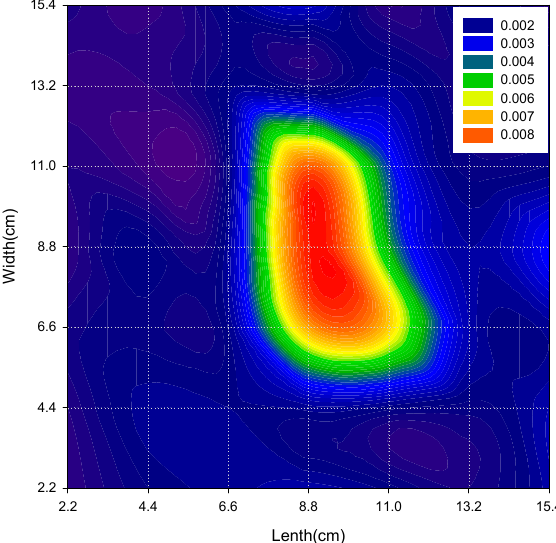
Figure 6. Ion precipitation contour distribution of southwest China gas-field water, cm.